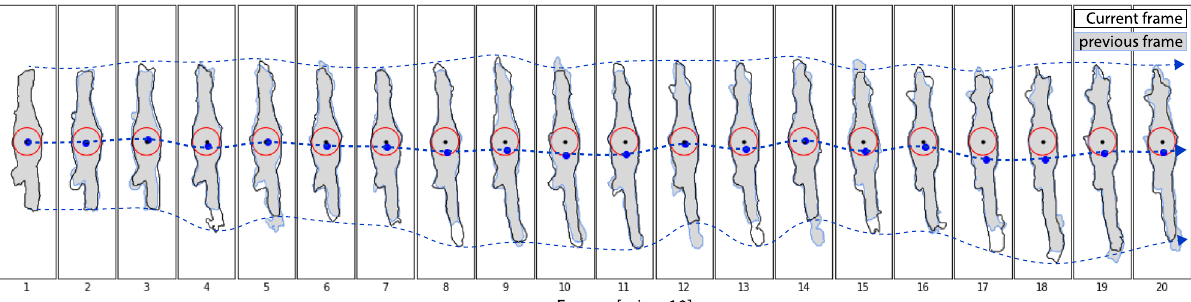
Figure 9. Cell vertex oscillations a series of frames showing the morphological evolution of a randomly selected cell with (cid:31) C indicated as black dot and the weighted center of mass as blue dot. While the direction-dependent morphology varies, the position of the weighted center of mass also varies. However, the center vertex position C does not exhibit a strong position variations, based on the definition of the center as the point with the largest (cid:31) distance to the cell